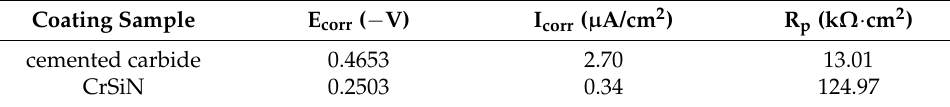
Table 2. Fitting parameters from polarization curves shown in Figure 10.